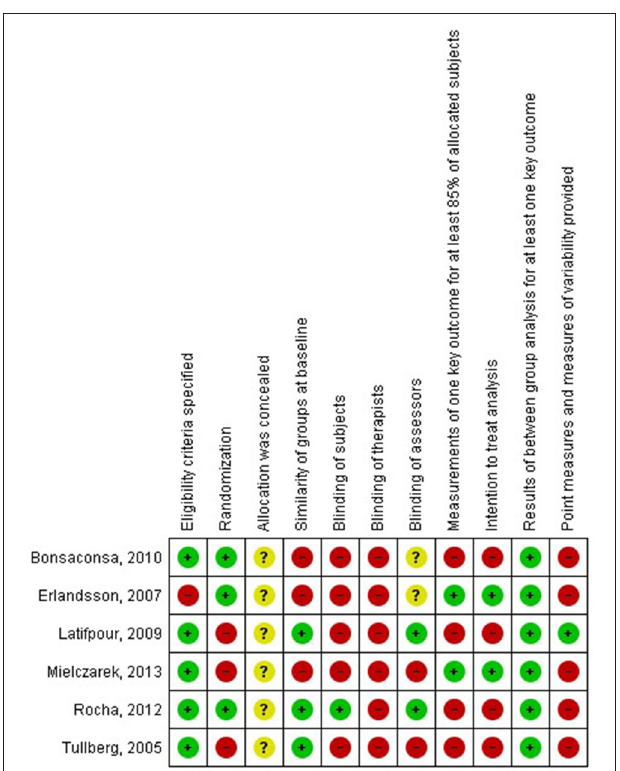
FIGURE 3 | Risk of bias summary: review authors’ judgements about each risk of bias item for each included study.